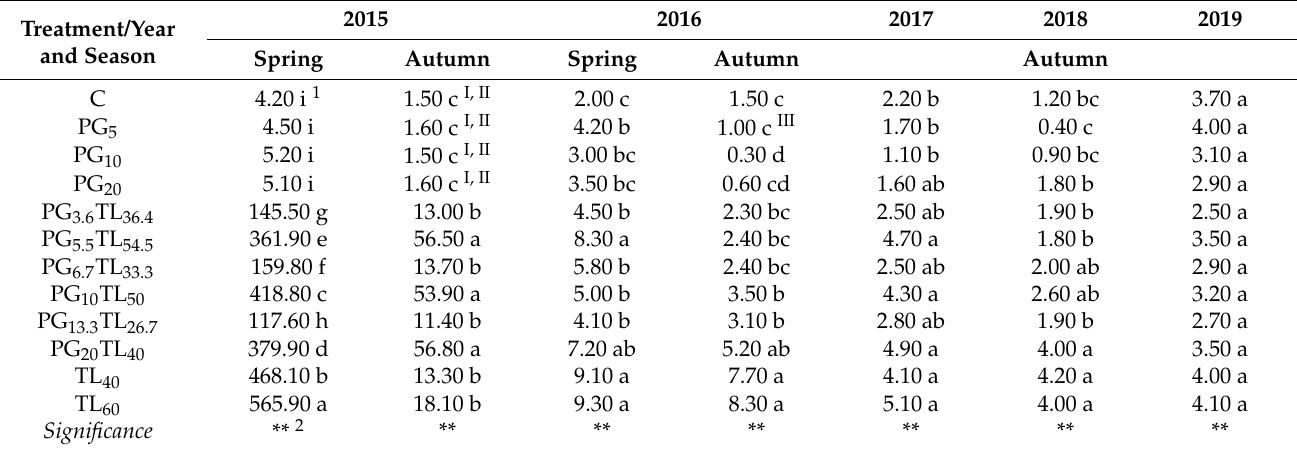
Table 10. Effect of treatments and years on the content of ammonium nitrogen (NH 4+ -N, mg kg –1 ) at 0–20 cm soil